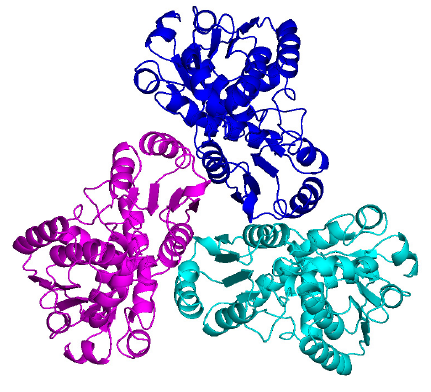
Figure 4. PDB deposited model of 4NF2. The 3-fold NCS axis is perpendicular to the plane of the